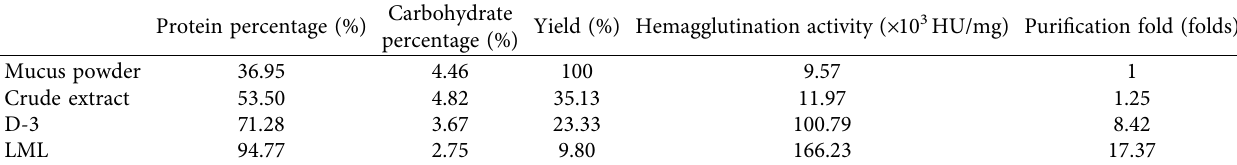
Figure 1: (a) Purification of lectin from loach skin mucus by DEAE-52: the four fractions (D-0, D-1, D-2, and D-3) were eluted by 0 (PBS, 20mM, pH 7.2), 0.3, 0.5, and 0.7M · NaCl solution (mixed with PBS, 20mM, pH 7.2) at a flow rate of 1mL/min, respectively; (b) purification of D-3 by Sephadex G200: the three fractions were eluted using PBS (20mM, pH 7.2) solution at a flow rate of Table 1: Extraction and purification of loach mucus lectin.